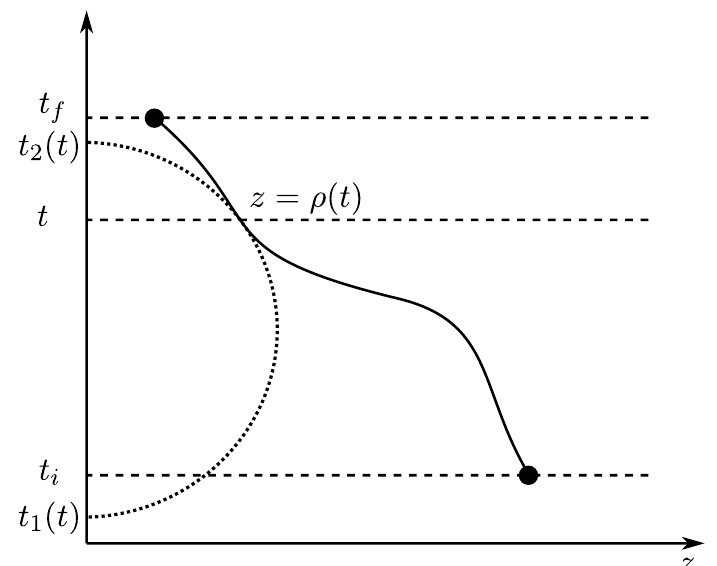
Figure 2 . We can parametrize a generic bulk curve ρ ( t ) by the pairs of boundary points ( t 1 ( t ) , t 2 ( t )) , such that a bulk geodesic connecting these two points is tangent to the bulk curve at z = ρ ( t ) . This way, the profile ρ ( t ) is encoded as a path in kinematic space, the space of bulk